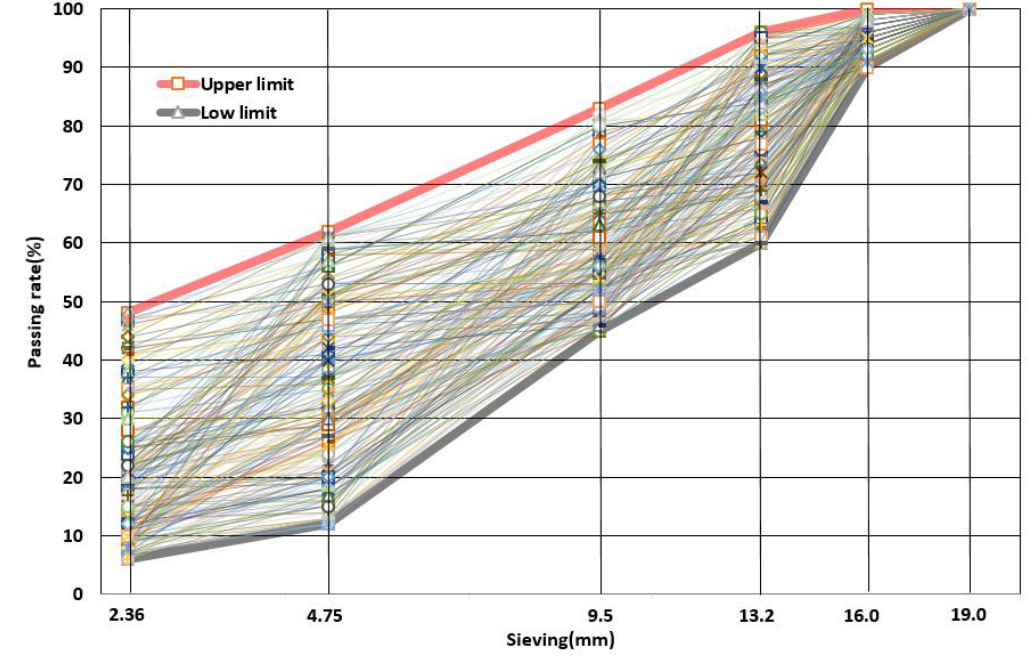
Figure 2. 200 coarse aggregate proportions of Gradation-16.